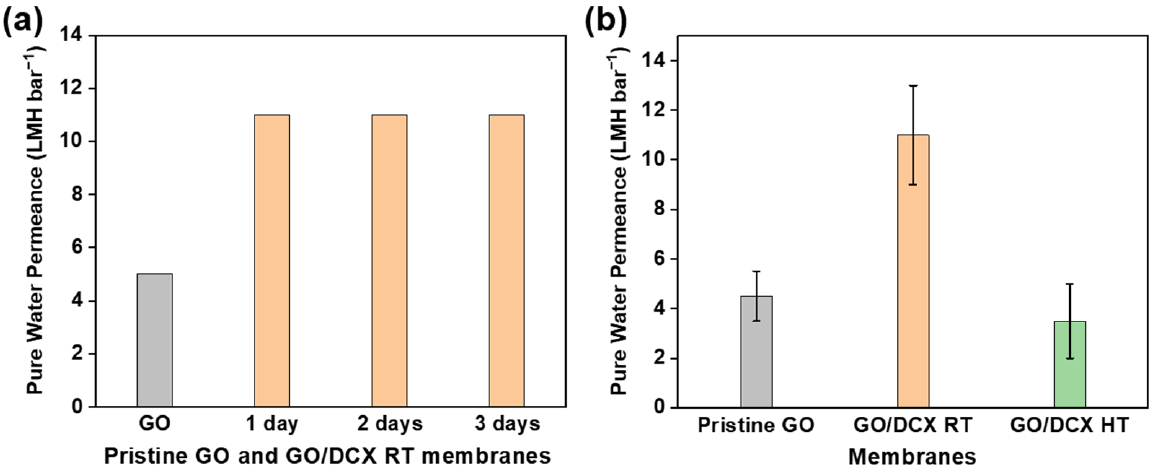
Figure 7. ( a ) Variations in the PWP of the GO membranes with DCX crosslinking time. ( b ) Compari- son of the PWPs between the GO, GO/DCX RT, and GO/DCX HT membranes to determine the effect of temperature.